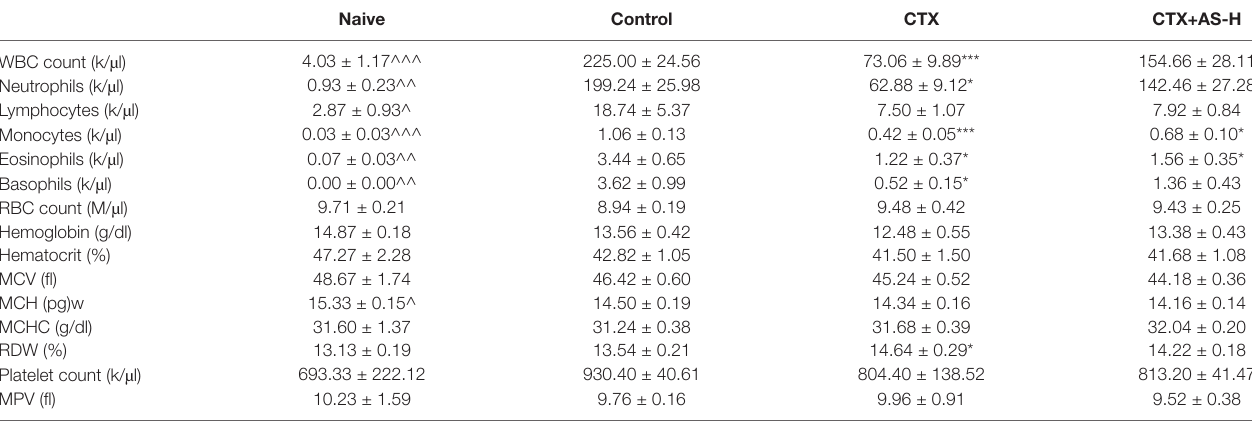
TABLE 2 | Hematological parameters in non-tumor-bearing (naive) mice and 4T1 breast tumor-bearing mice after CTX and/or AS treatments.